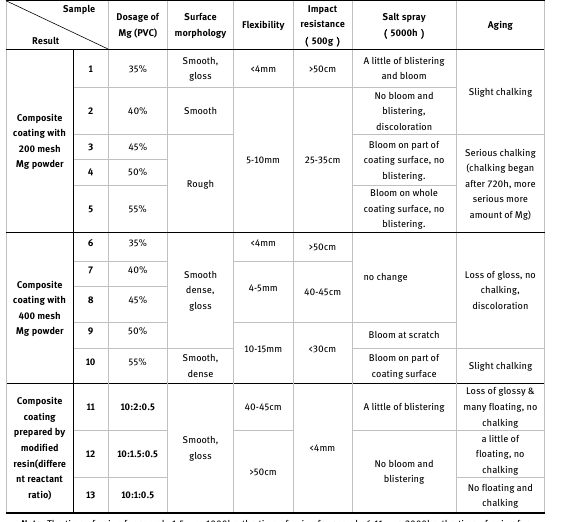
Table 1: Performance of the coatings prepared by different Mg pow- der and resin Sample